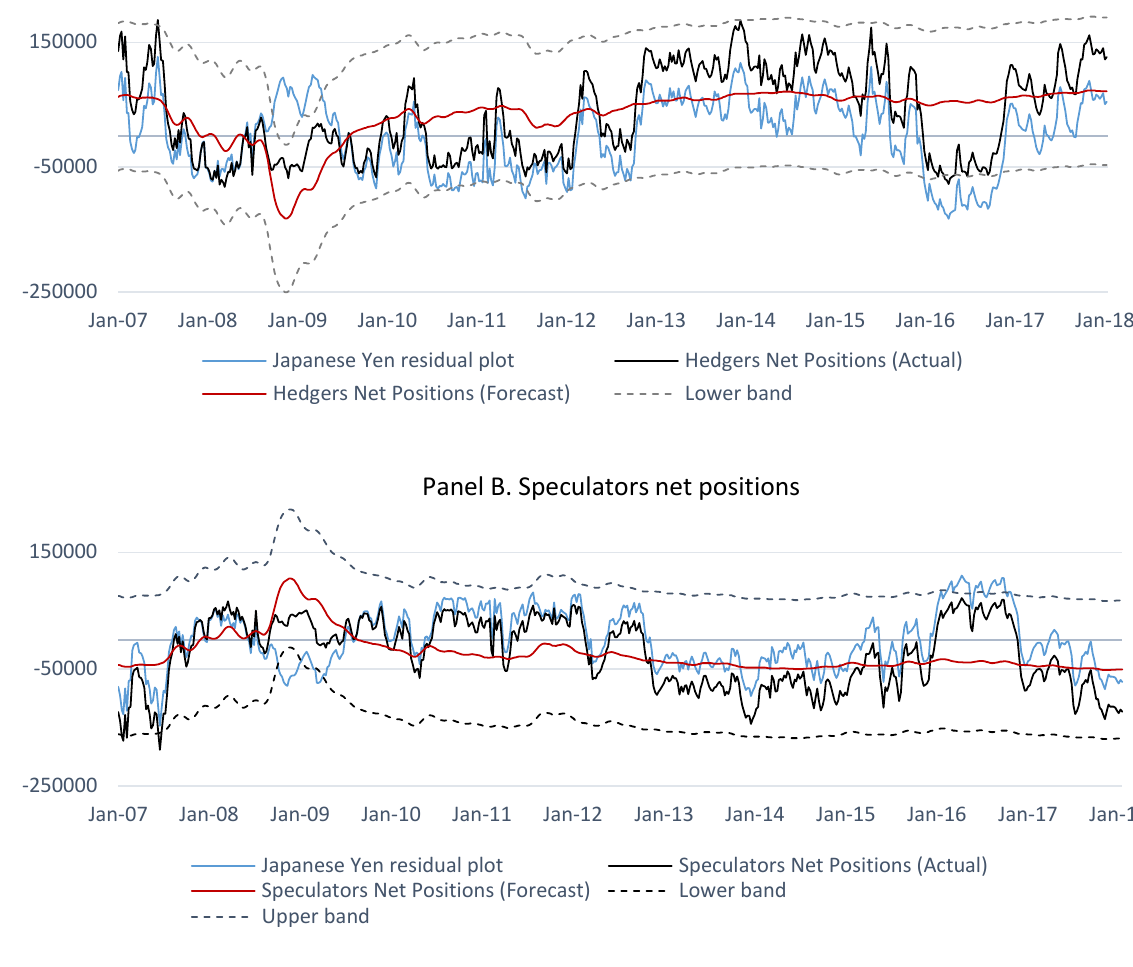
Figure 2. Japanese Yen hedgers and speculators net